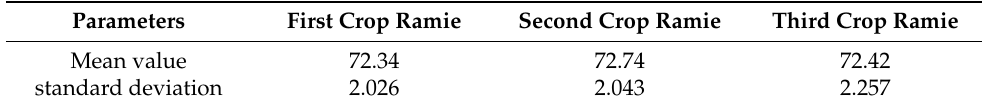
Table 5. Normal distribution parameters of three crops of ramie.